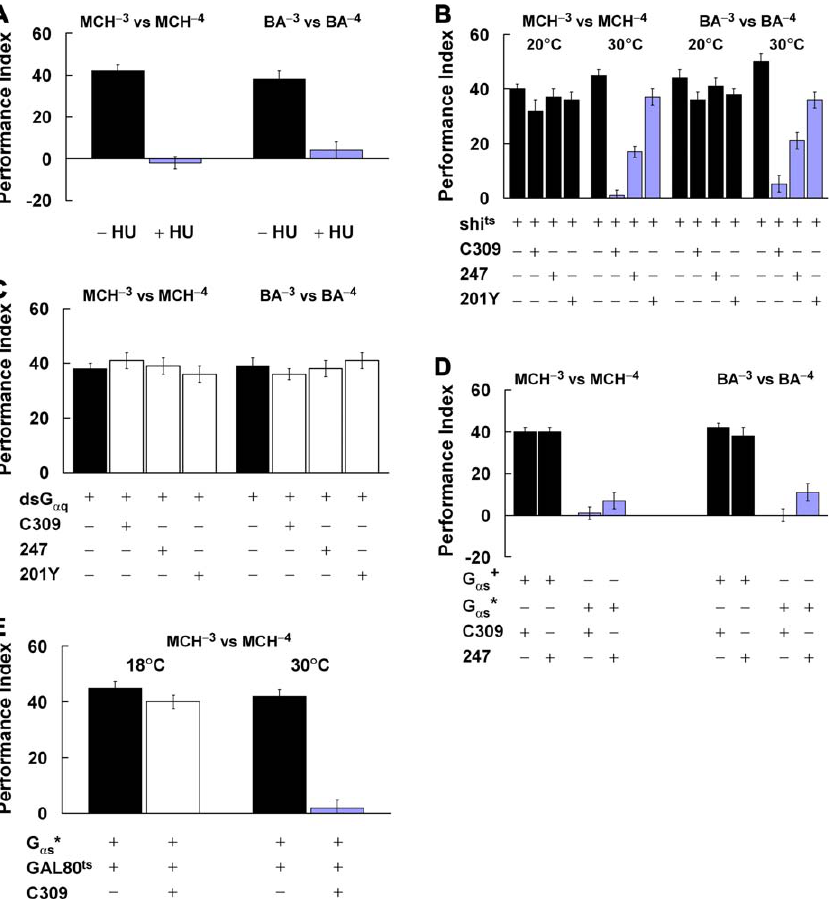
Figure 3. Conditioned Odor Intensity Discrimination Requires Synaptic Transmission from MB and Depends on G a s Signaling Conditioned odor intensity discrimination between different concentrations of MCH (left panels) or BA (right panels) was (A) abolished by MB ablation ( þ HU), (B) disrupted by transient block (30 8 C) of synaptic transmission from MB in C309/shi ts , 247/shi ts , or 201Y/shi ts flies, (C) not affected by disruption of G a q in MB of ds G a q /C309, ds G a q /247, or ds G a q /201Y flies, (D) severely affected by developmental disruption of G a s in MB of G a s */C309 or G a s */247 flies, and (E) abolished in an adult-specific manner by disruption of G a s (at restrictive temperature, 30 8 C, for 3 d) in MB of G a s *, GAL80 ts /C309 flies. n ¼ 6 PIs for each group.